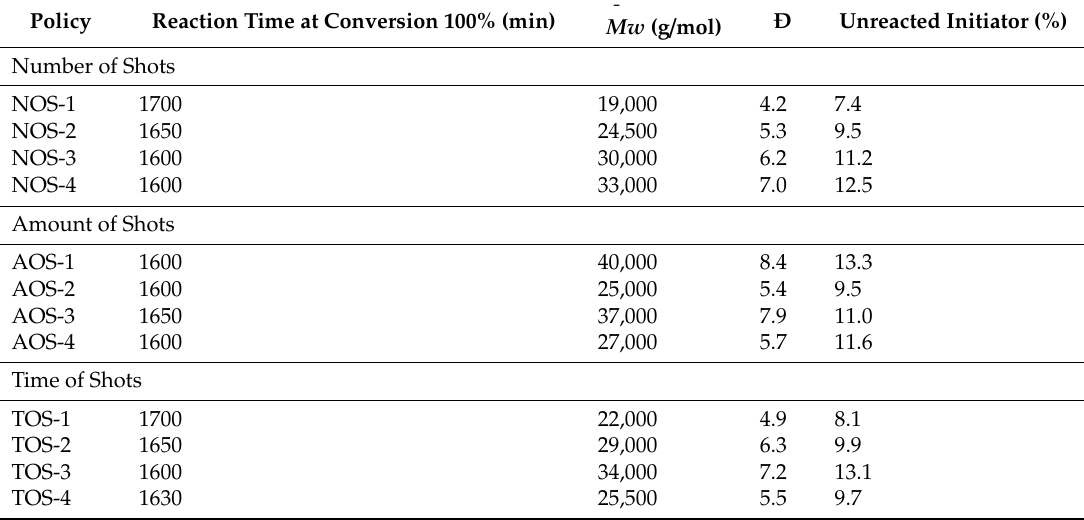
Table 5. Simulated data of free radical polymerization of methyl methacrylate in solution (Case 3) according to the various initiator feeding policies (NOS, AOS, and TOS of Table 3, with an equal total amount of